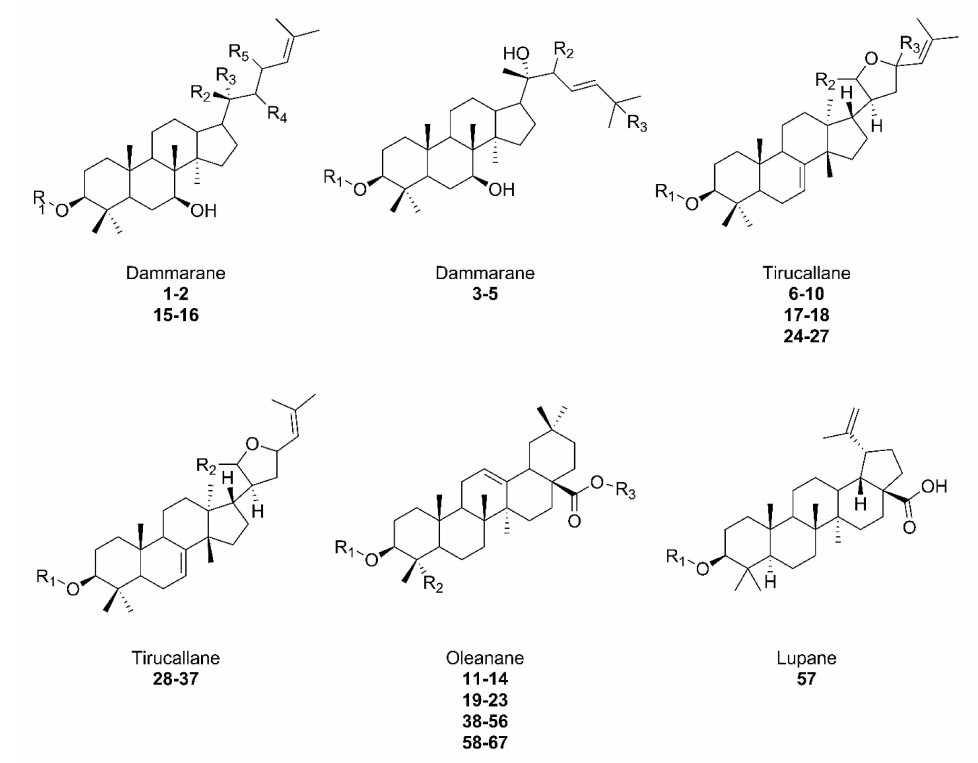
Figure 3. Overview of saponin structures present in S. mukorossi . The structure extensions are shown in Table 1 with the corresponding